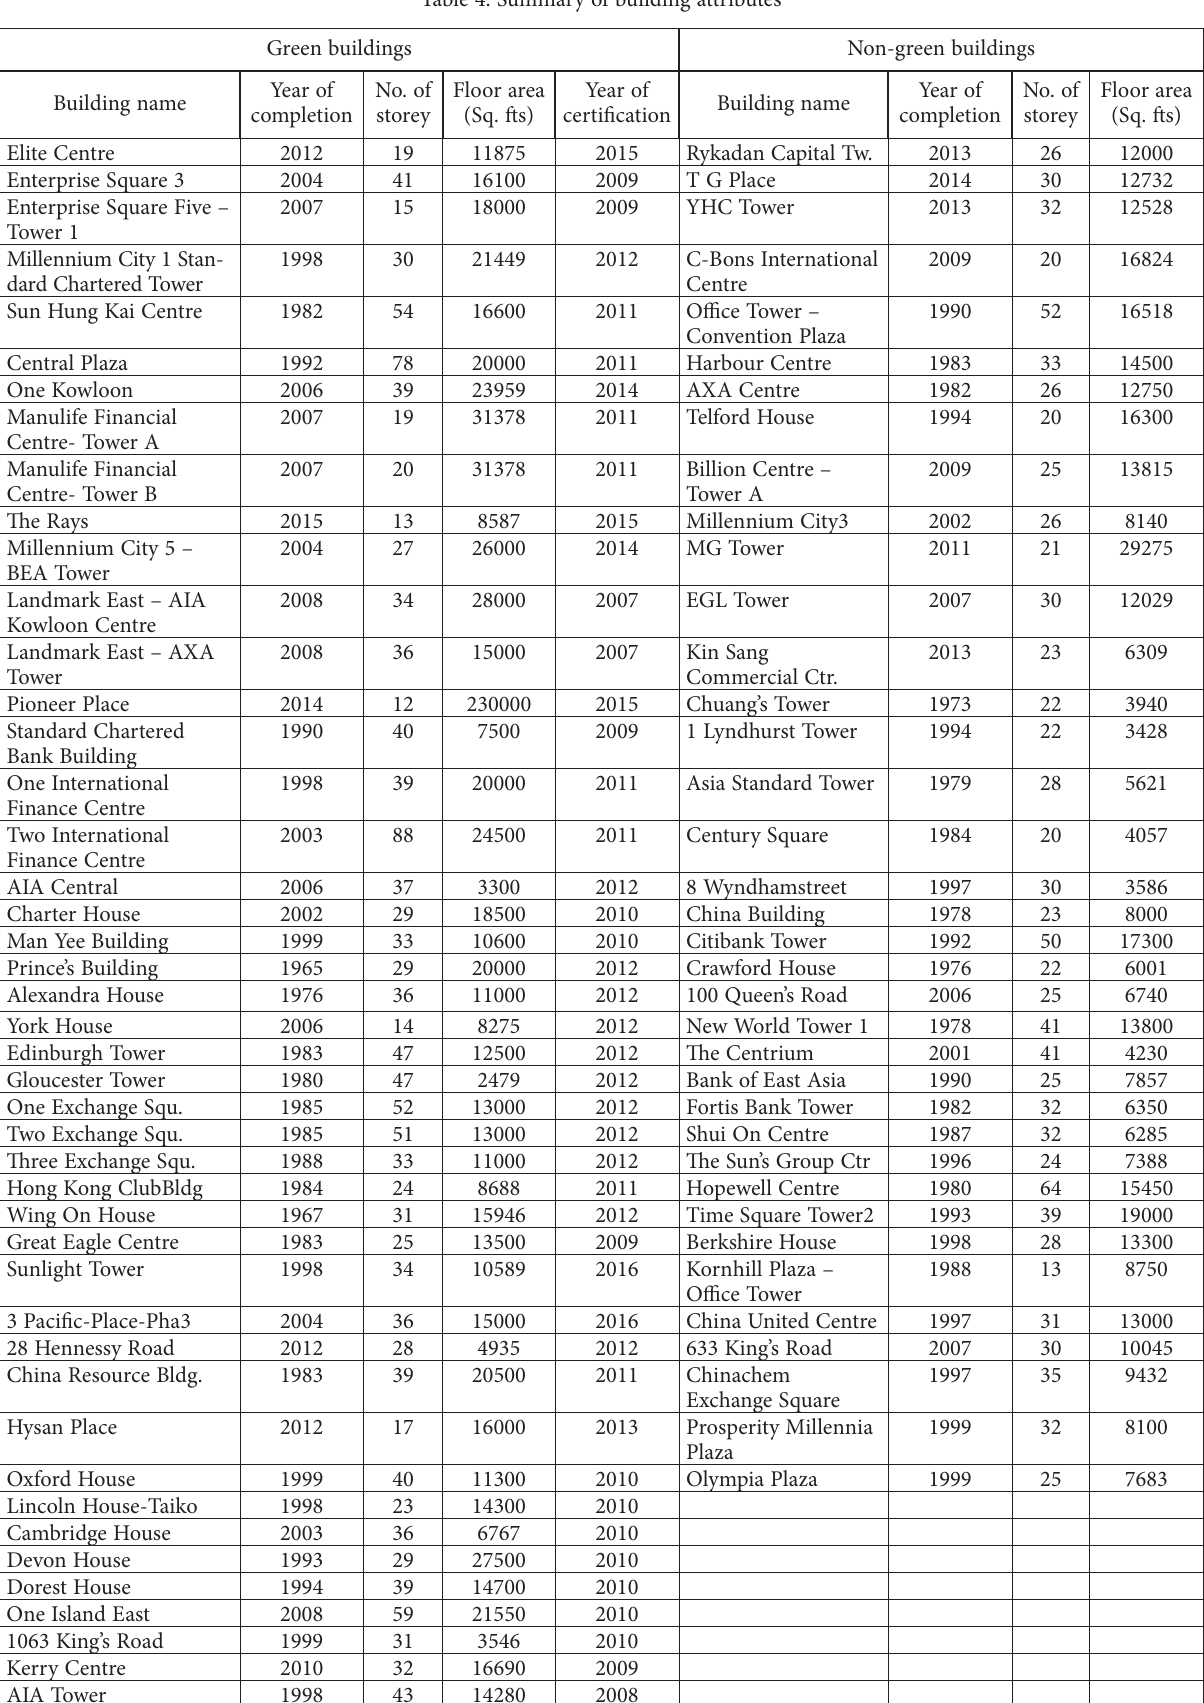
Table 4. Summary of building